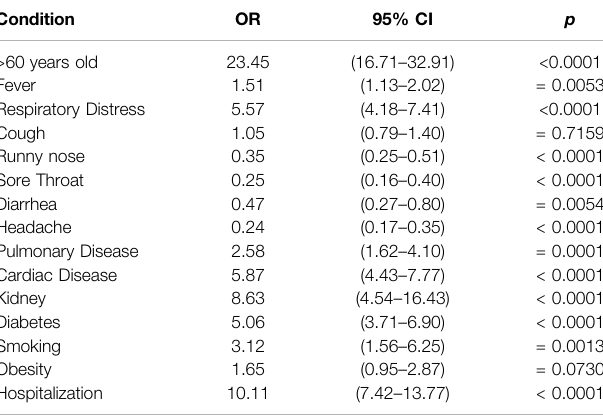
TABLE 8 | Odds ratio for validation